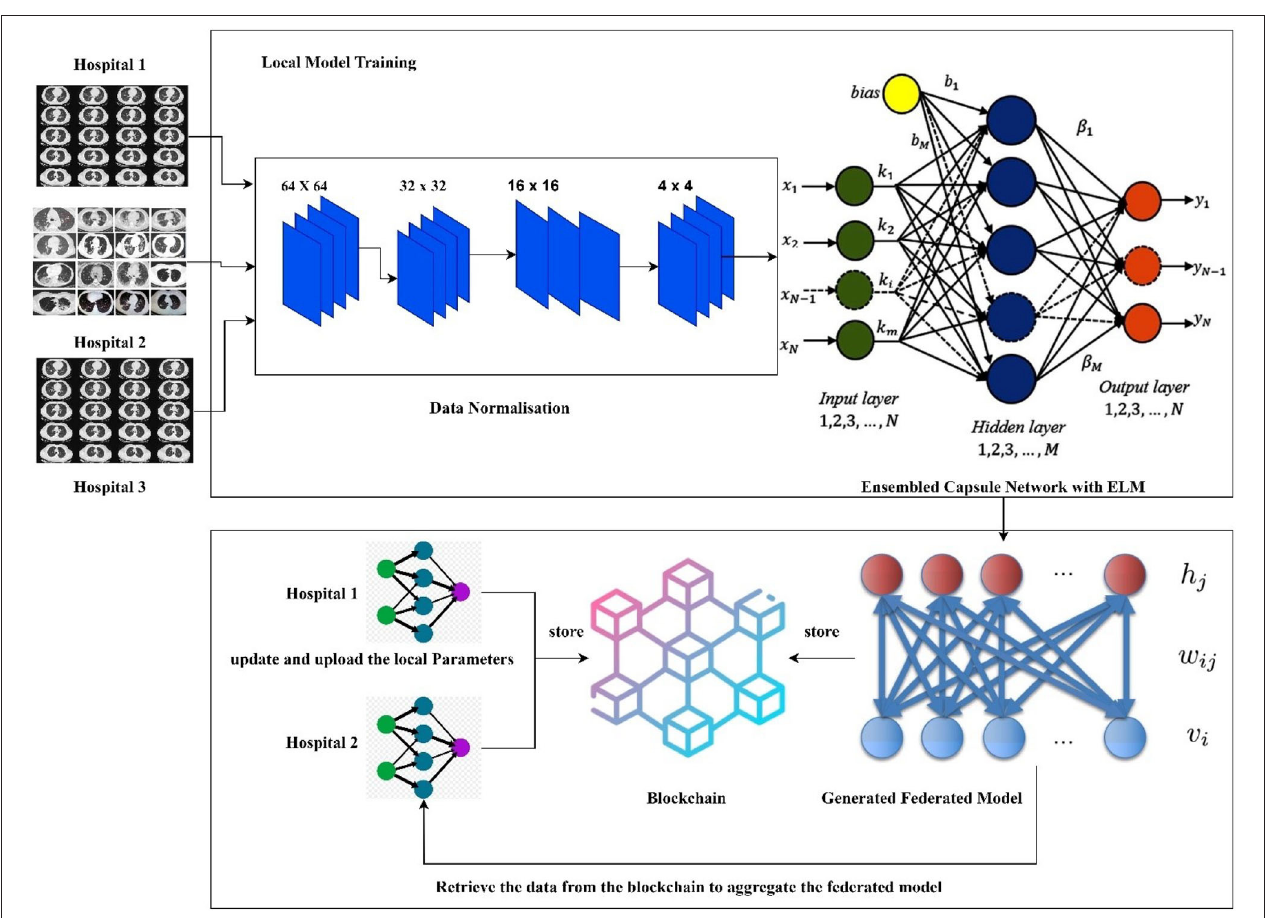
FIGURE 1 | Proposed framework of the